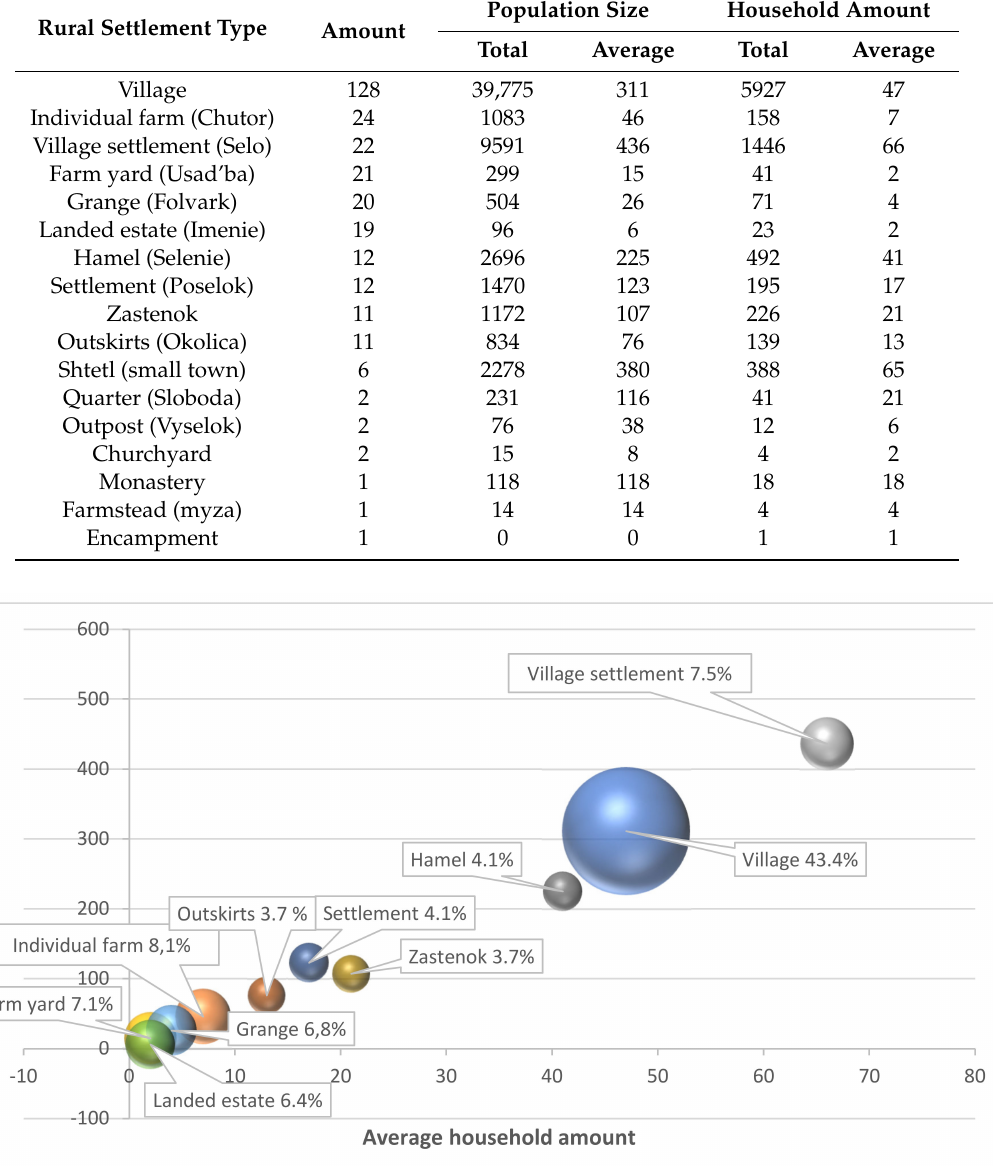
Table 2. Distribution of rural settlements by population size and household amount in the pre-revolutionary period (within the current boundaries of the Mogilev district).